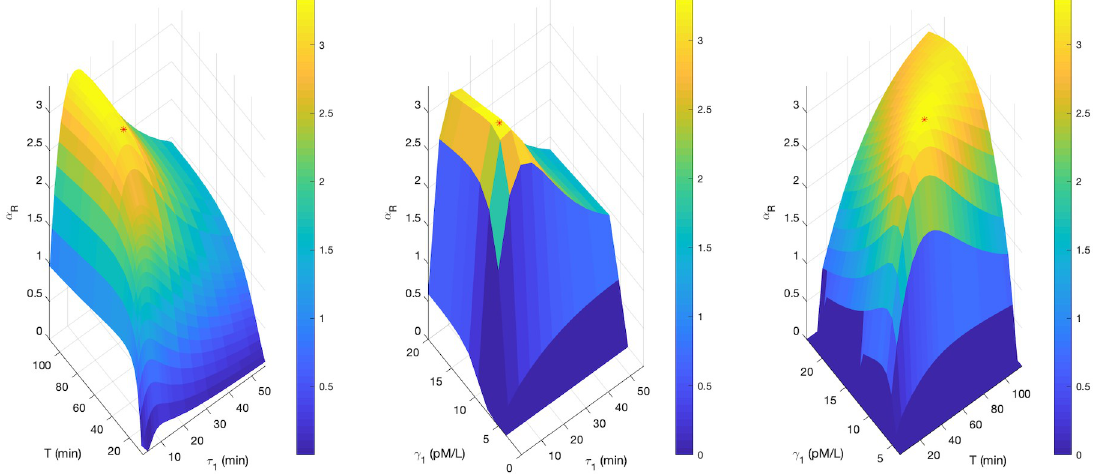
Fig 6. Cellular responsiveness for a healthy person as function of T and τ 1 ; γ 1 and τ 1 ; γ 1 and T . The third quantity of the triplet ( γ 1 , τ 1 , T ) results from the optimisation constraint given in Eq (15). Simulation parameters are given in Table 1 and S2 Table.